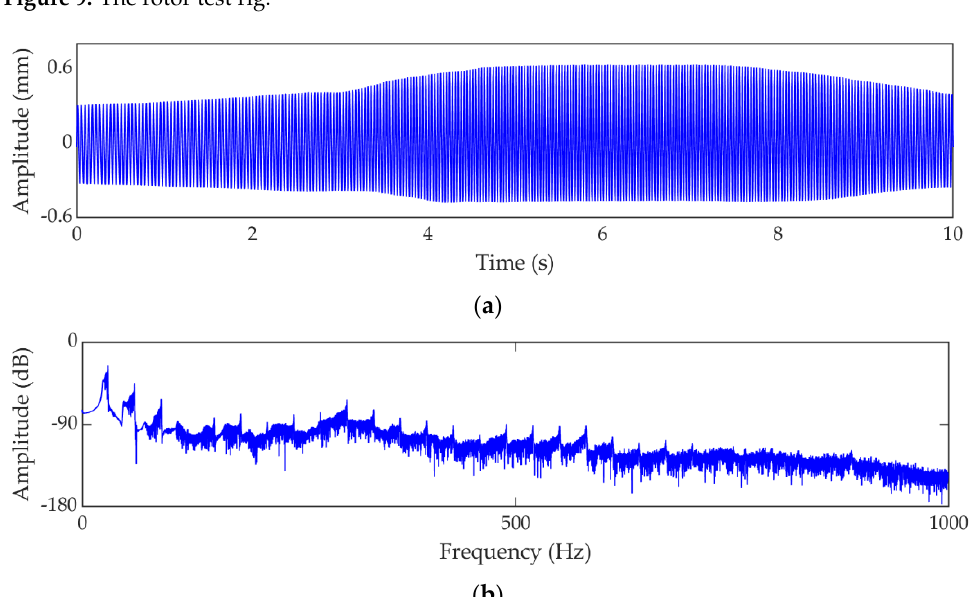
Figure 10. ( a ) The waveform of the vibration signal collected from the rotor test rig; ( b ) the amplitude spectrum of the signal.